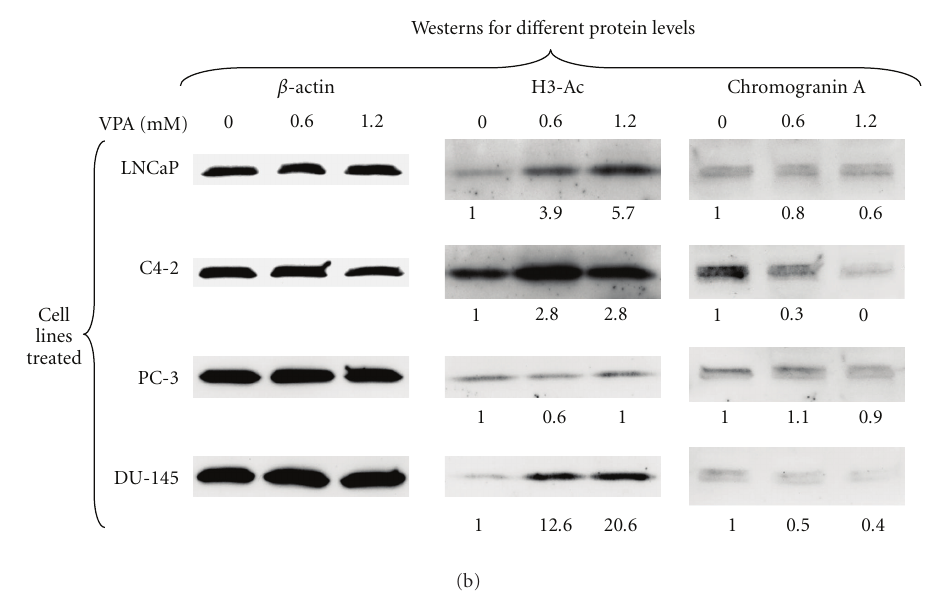
Figure 1: Chromogranin A staining in prostate cancer cells treated with VPA in vitro. (a): Representative images of CgA staining for cell pellet sections from control and VPA-treated groups: LNCaP, C4-2, PC-3, and DU-145 (Scanned at 20X magnification using the APERIO imaging system). The tissue specimens of normal human prostate were positive internal controls for CgA staining. (b) Western blot analysis of cells treated in vitro . LNCaP, C4-2, DU-145, and PC-3 cells treated with VPA show induction of acetyl-H3, verifying HDACI activity, and downregulation of the NE marker